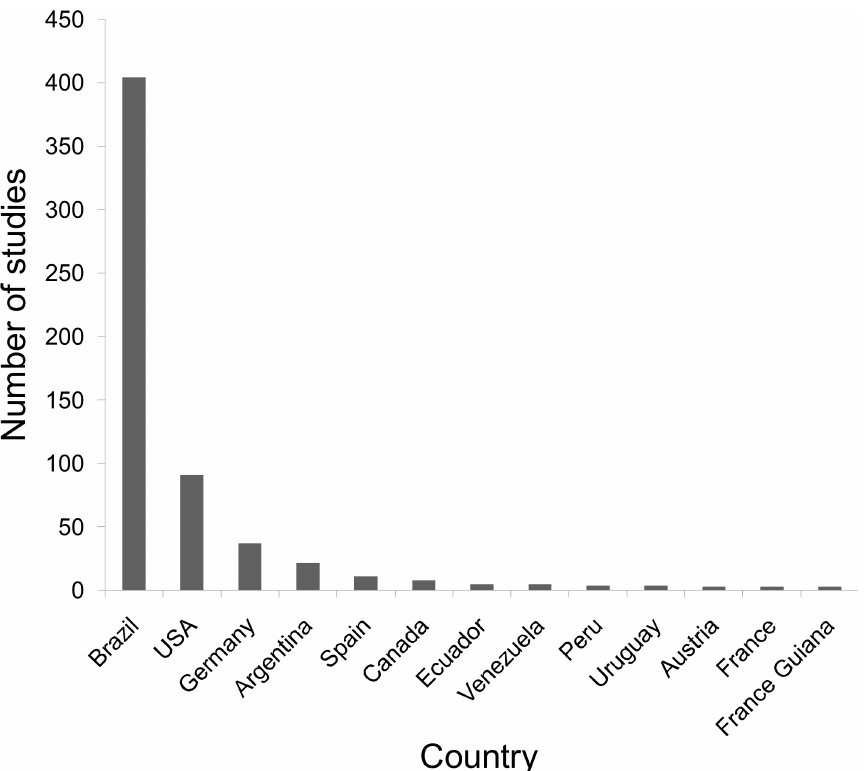
Fig 8. Number of studies with descriptions of advertisement calls of Brazilian anurans published per country (affiliated institution of the first author).